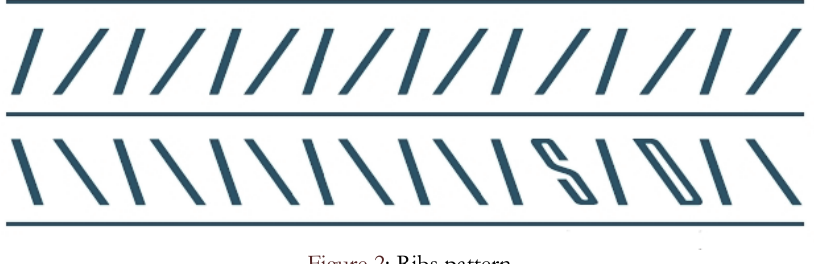
Figure 2: Ribs pattern.